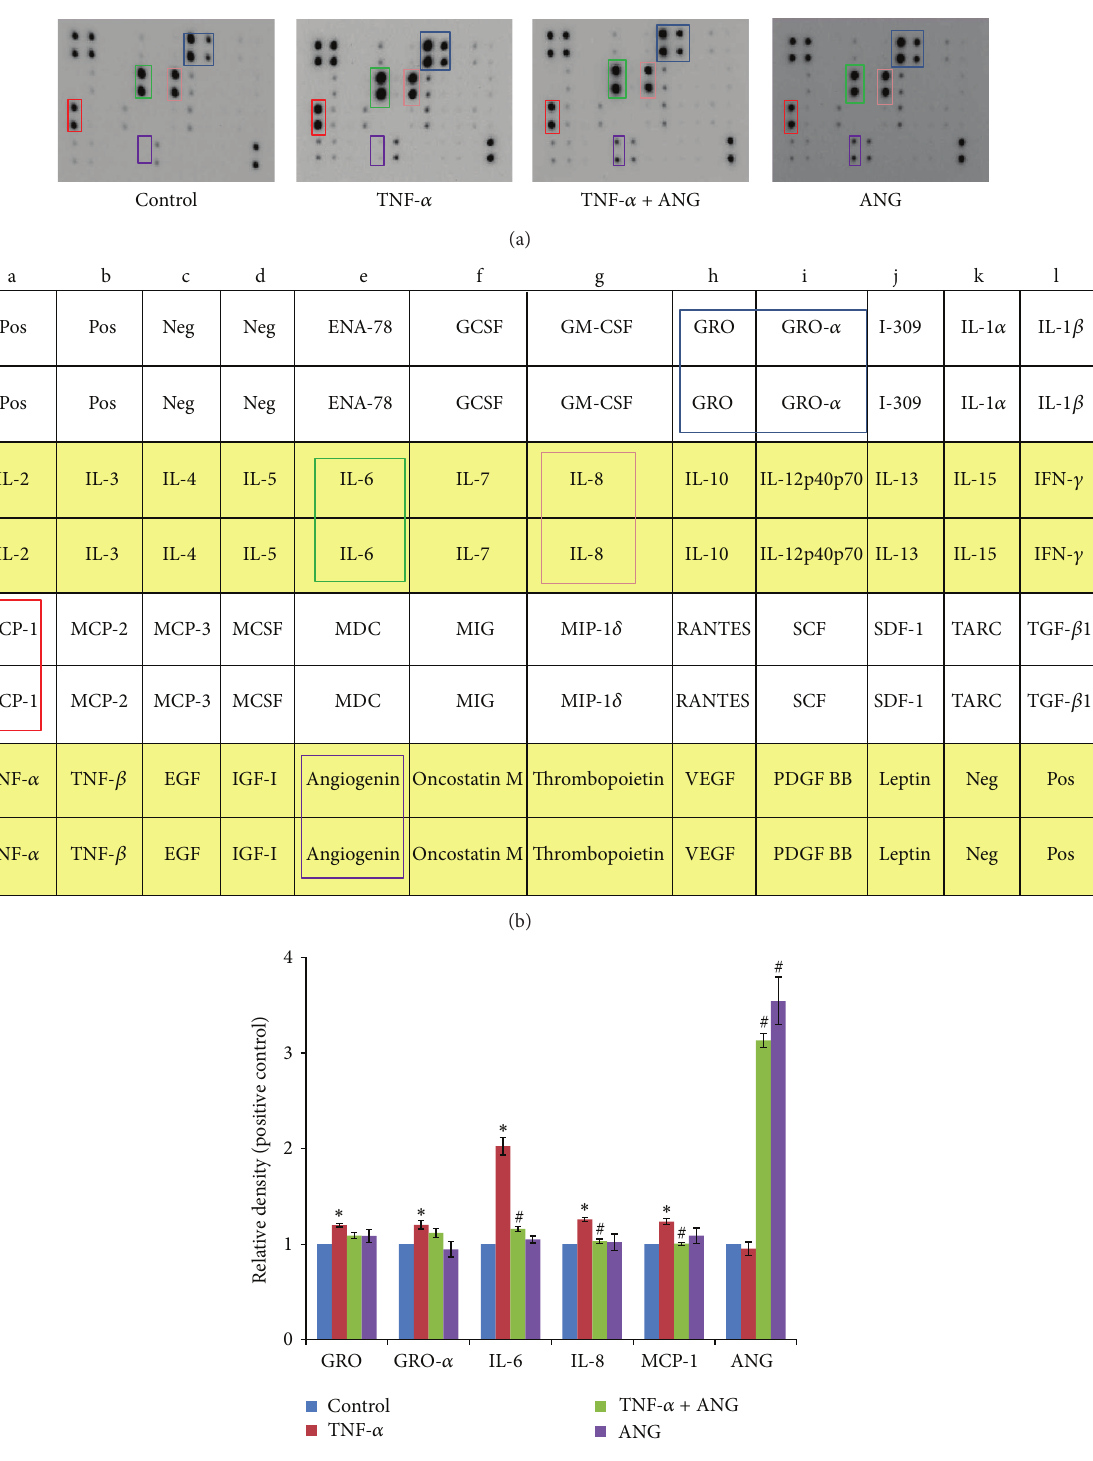
Figure 2: Inflammatory cytokine profiles in HCF culture medium. (a) Treatment with TNF- 𝛼 (20 ng/mL) resulted in amplification of five inflammatory cytokines and chemokines (GRO and - 𝛼 , IL-6 and -8, and MCP-1). Treatment with ANG (2 𝜇 g/mL) resulted in reduction of these inflammatory cytokines and chemokines. Treatment with ANG alone only induced upregulation of ANF area. (b) Custom human growthfactorantibodyarraymap.Pos:positivecontrol;Neg:negativecontrol.(c)Relativedensityofinflammatorycytokinesandchemokines. The signal intensities were observed and quantified using a chemiluminescence imaging device. The values presented in the bar graph are the mean ± SE from triplicate experiments ( ∗ 𝑃 < 0.05 versus control cells; # 𝑃 < 0.05 versus TNF- 𝛼 treated cells). GRO: growth regulated oncogene; MCP: monocyte chemotactic